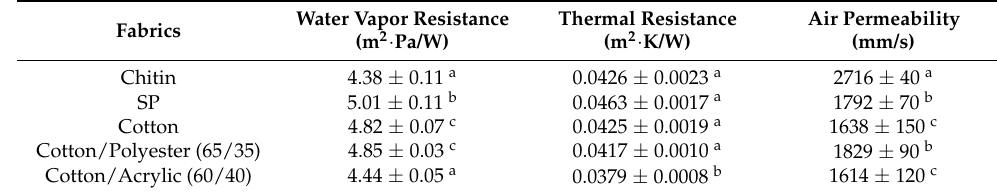
Table 7. The results obtained through skin model for fabrics of soy protein (SP), chitin, cotton, cotton-based